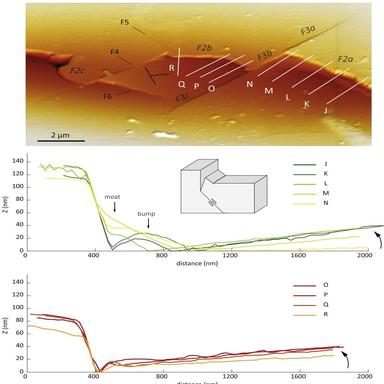
AFM topographic profiles across the main fracture (F2) of sample WS1.2. The nDTM suggests that the fracture is mixed mode shear. The curved arrows on the graphs indicate the interpreted sense of rotation of the hanging wall with increasing fracture displacement. The dip symbol on the oblique view underlines the sense of pyroxene crystal block rotation. The inset is from.